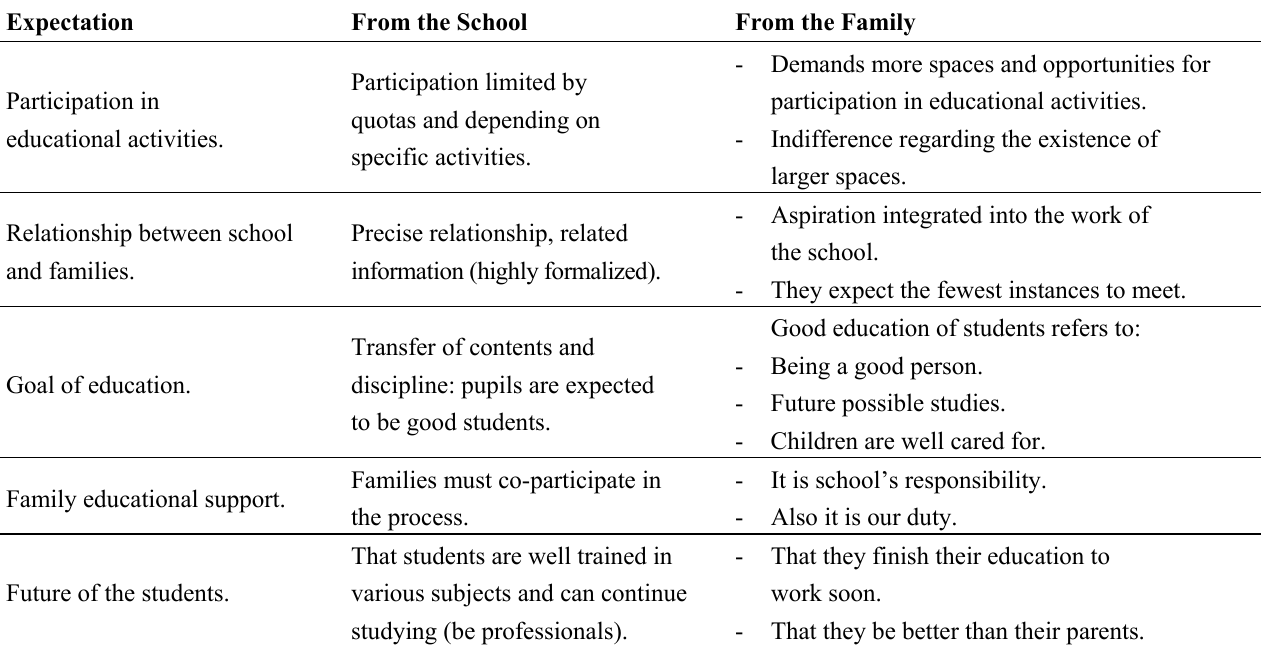
Table 5. Expectation gap between school and families.